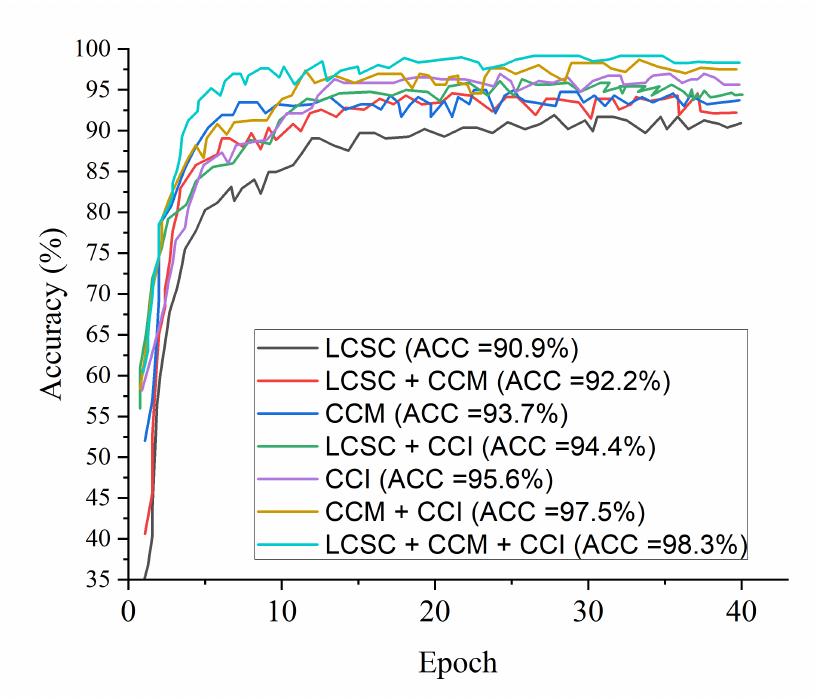
Figure 10. Accuracy curves for the proposed multi-channel in comparison with the single-channels and dual-channels.